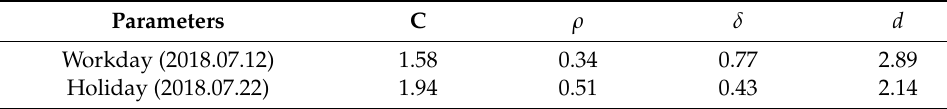
Table 1. Parameter optimization results of the MKELM model. Parameters